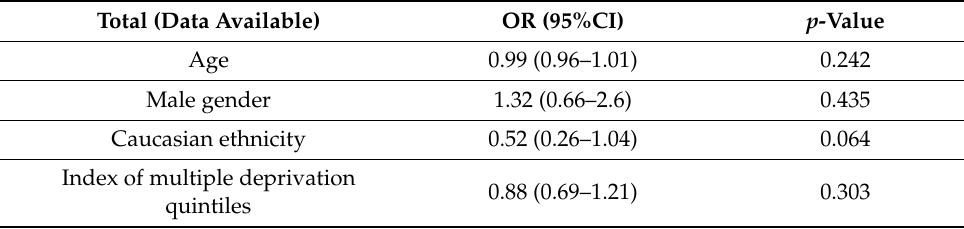
Table 3. Univariate logistic regression analysis: odds of not receiving a vaccine. Total (Data